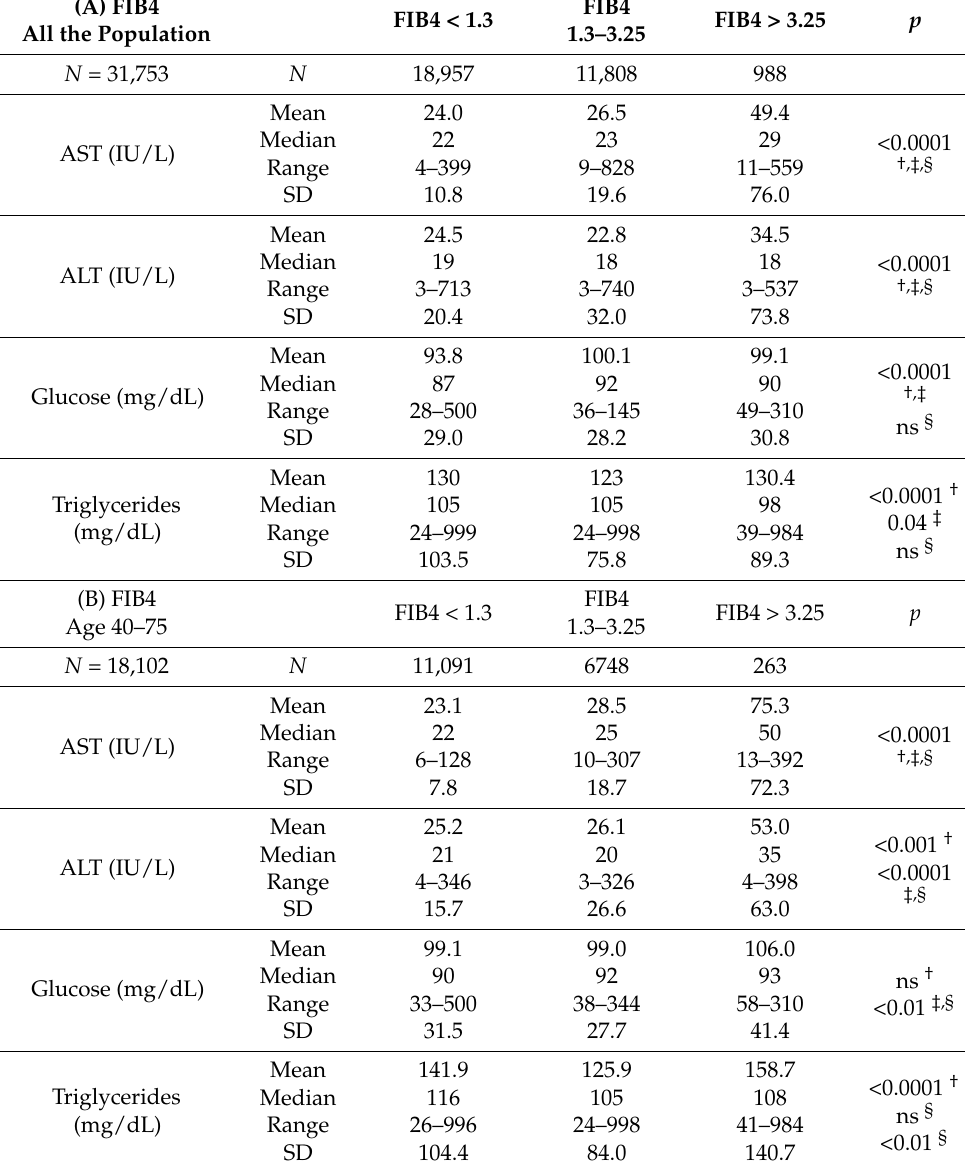
Table 1. Biochemical parameters distributed by FIB4 cut-offs (A) in all the population affected ( N = 31,753) and (B) in the subset of patients aged 40 to 75 years ( N = 18,102). (A) FIB4 All the